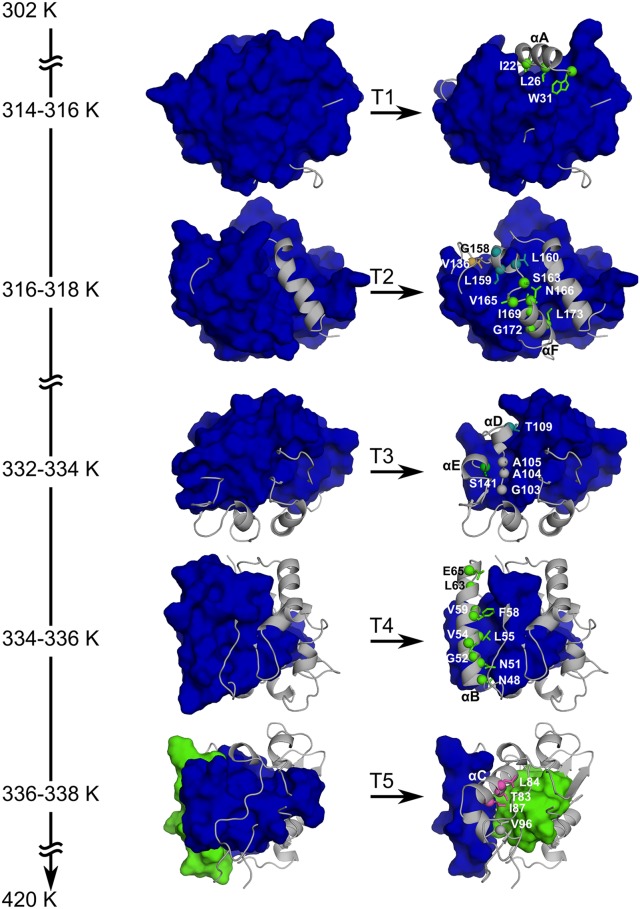
Thermal unfolding trajectory of WT BsLipA showing transitions for which weak spot residues were identified.Uniformly colored bodies represent rigid clusters; for clarity, only the largest rigid cluster (blue) is shown for the first four transitions (T1–T4), and the two largest rigid clusters (blue and green) are shown for the last transition (T5). Cα atoms of the identified weak spot residues are shown as spheres, and side-chain atoms are shown in stick representation. Weak spot residues are colored according to the rigid cluster they are part of (rigid clusters are assigned blue, green, magenta, cyan, and orange colors in the descending order of their size in terms of the number of residues); a weak spot residue colored in gray indicates that it is part of a rigid cluster composed of less than three residues. Weak spot residues that are highly conserved in the multiple sequence alignment of the lipase family are not shown. Important helices that segregate from the largest rigid cluster at the respective transition are labeled.